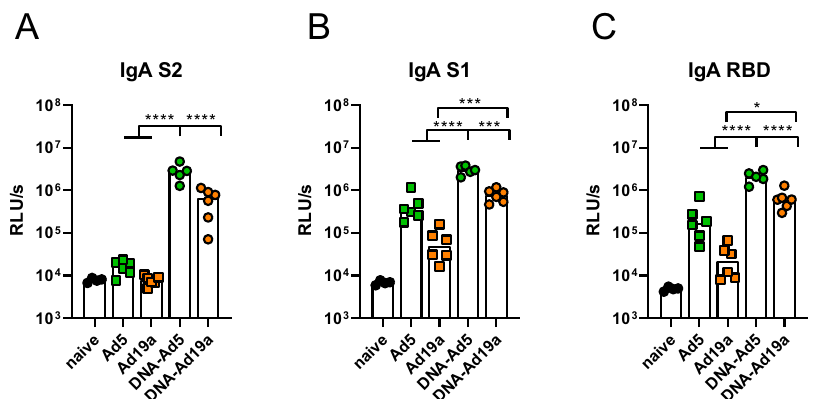
Fig. 2 Mucosal, spike-speci fi c IgA responses. BALB/c mice were vaccinated according to Fig. 1A. BAL samples were tested for spike-speci fi c IgA directed against the domains of S2 ( A ), S1 ( B ), or RBD ( C ) by ELISA (dilution: 1:10). Bars represent group medians overlaid with individual data points; naïve n = 4; DNA-Ad5 n = 5; other groups n = 6. Data were analysed by one-way ANOVA followed by Tukey ’ s post test. Statistically signi fi cant differences are indicated only among the different vaccine groups; p values indicate signi fi cant differences (* p < 0.05; ** p < 0.005; *** p < 0.0005; **** p < 0.0001).